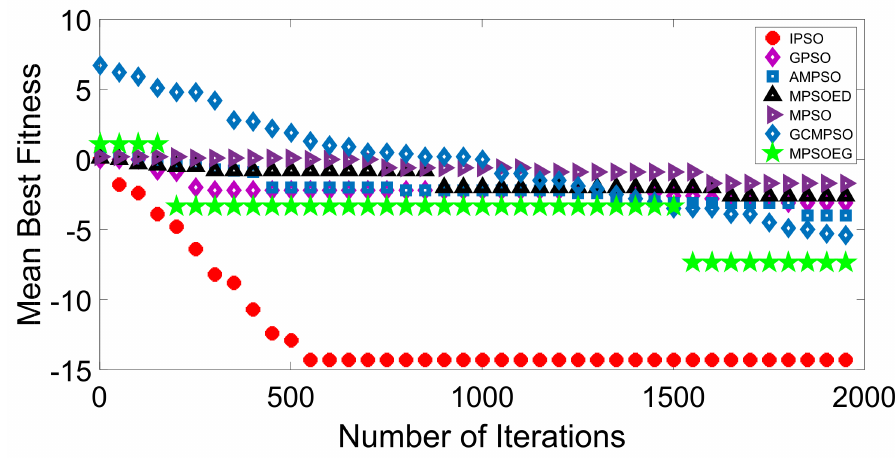
Figure 1. Algorithms convergence plots on f 1 .